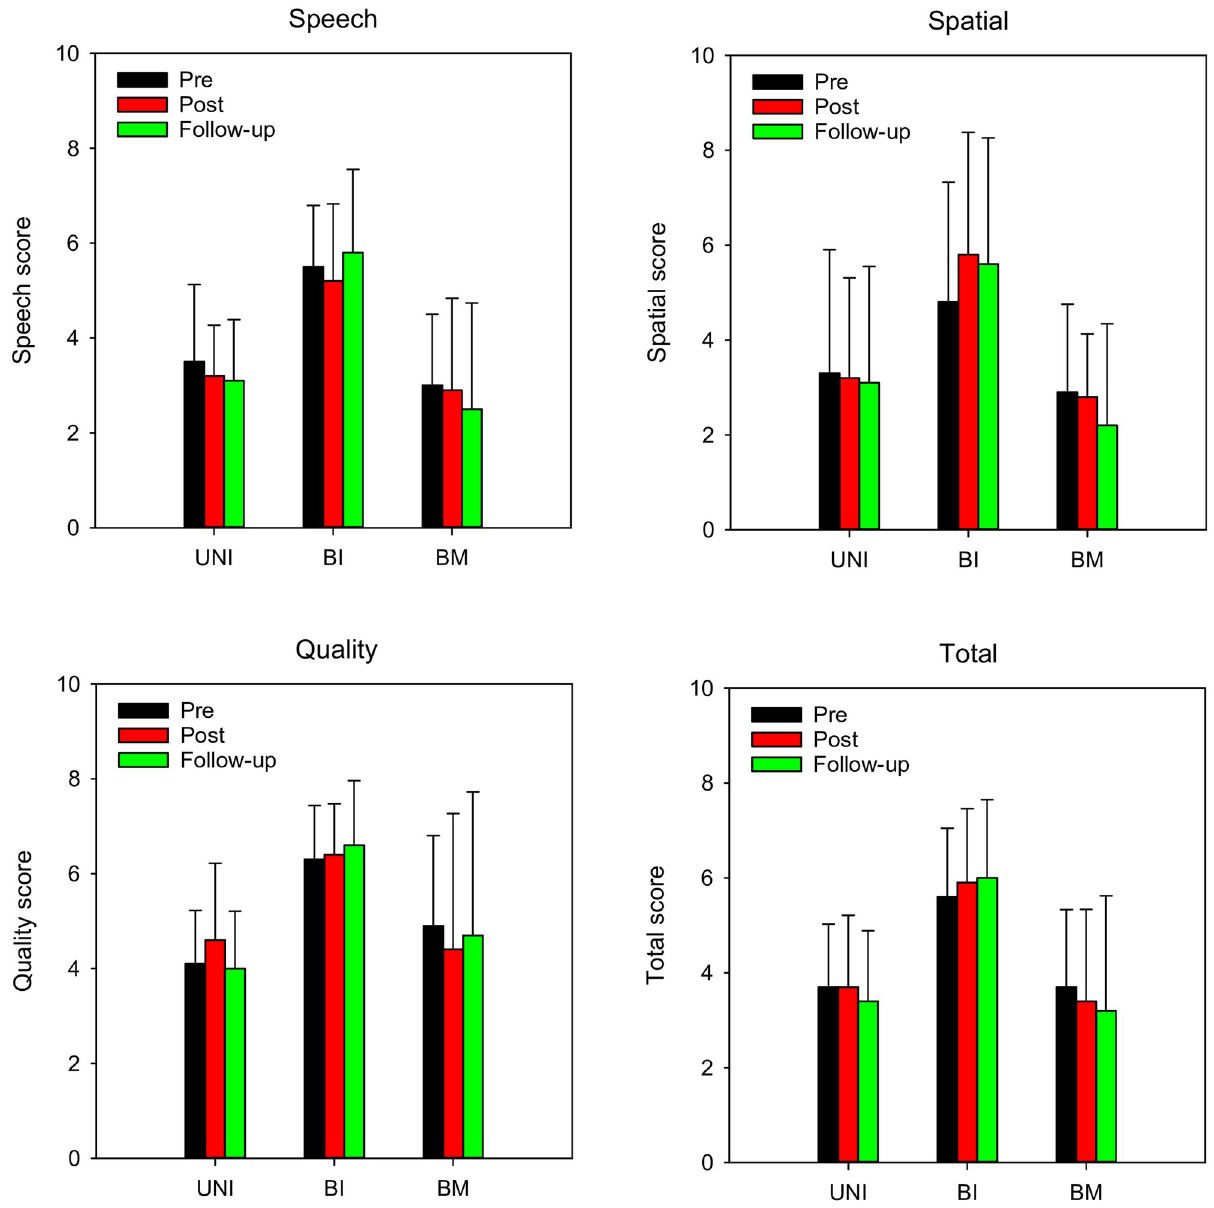
Fig 7. Mean pre-training, post-training, and follow-up SSQ scores for the different CI groups. Data are shown for the speech, (top left), spatial (top right), and quality subsections (bottom left), and for the total score (bottom right). In all panels, the error bars show the standard deviation.